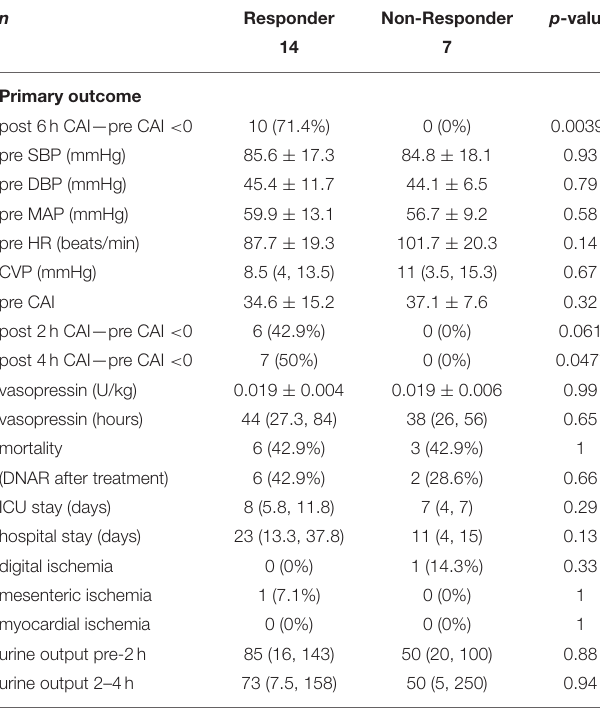
TABLE 1 | Differences in baseline characteristics between vasopressin loading responders and non-responders.